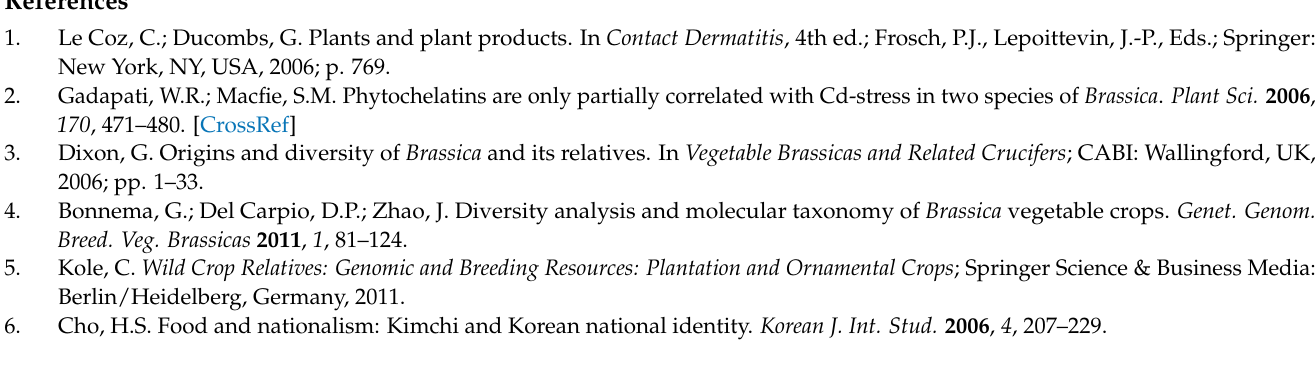
Figure 6. Variable importance in the projection (VIP) values linked with OPLS-DA clustered based on ten glucosinolates. Variable shown in order of major contribution to two statuses ( a ); and four origins ( b ).